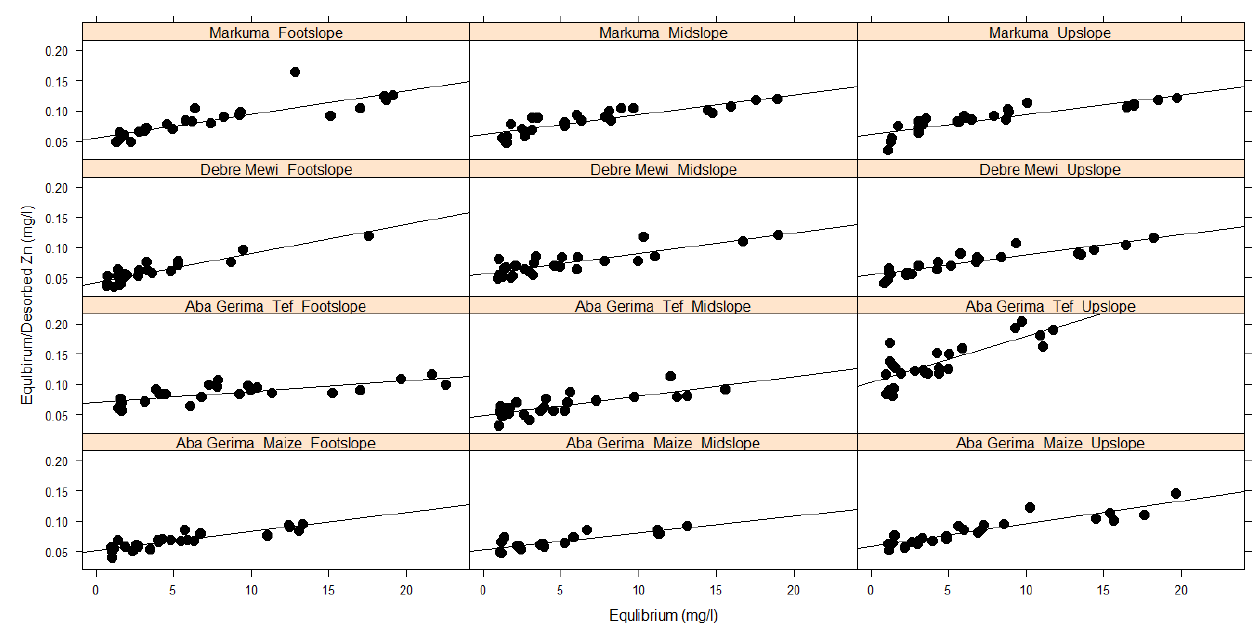
Figure 5. Desorption data fitted to the Langmuir isotherm.